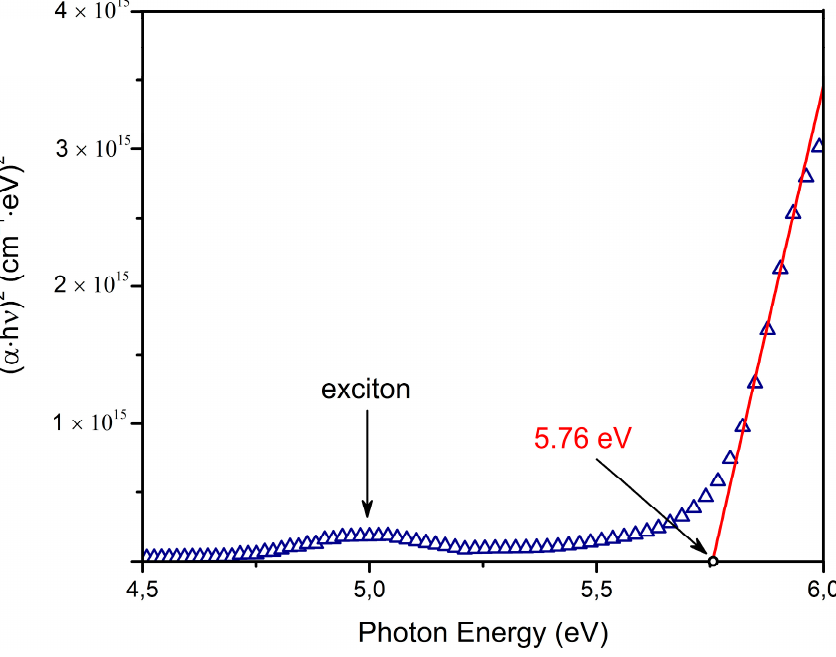
Figure 5. Optical absorption spectra of the Y 2 O 3 film, shown in Tauc coordinates for direct allowed interband transitions. Arrows indicate the corresponding optical transparency gap with a ±0.01 eV accuracy. The band with its maximum at 5.0 eV is associated with exciton absorption.